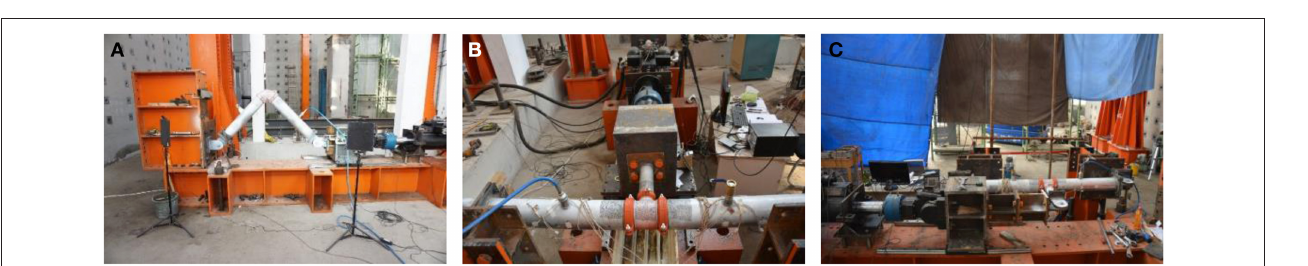
Frontiers in Built Environment |